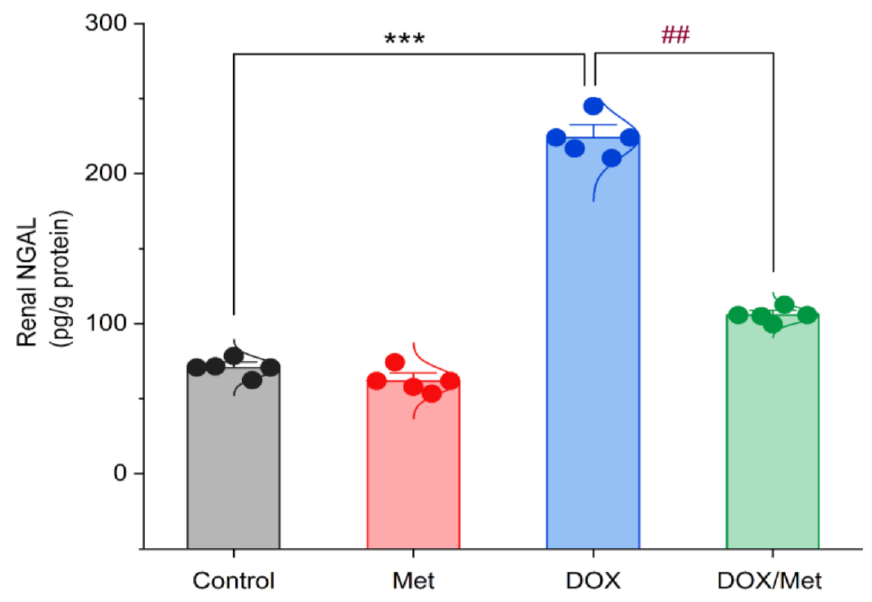
Figure 4. Bar-dot plot of the prophylactic effect of Met on DOX-induced changes on renal NGAL content. Student’s t -test was used for statistical comparisons. Data are expressed as mean ± SEM. Colored dots indicate each individual value and colored curves represent the distribution of each data point. *** p < 0.001 vs. control group and ## p < 0.01 vs. DOX